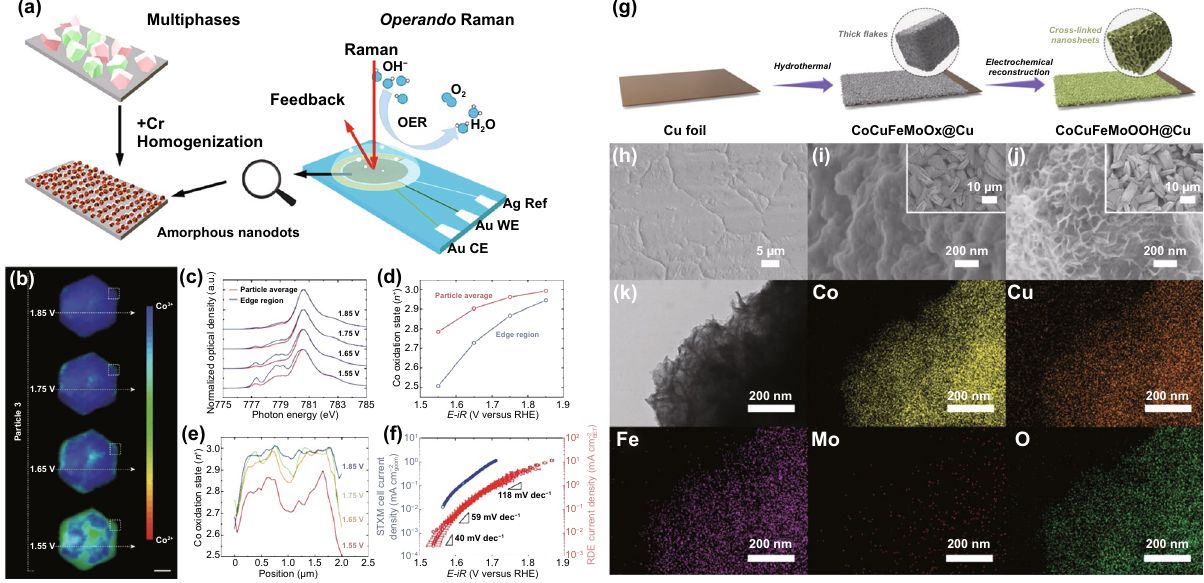
Fig. 14 a Scheme of the amorphization by introducing Cr and operando Raman testing during OER. Reprinted with permission from Ref. [199]. Copyright Year 2020. American Chemical Society. b Phase maps of a β-Co(OH) 2 particle at applied voltages in different OER Tafel regions. Scale bar, 500 nm, c Co LIII-edge STXM–XAS spectra of the particle average and the boxed edge region in a, showing a reduced Co oxidation state at the edge of the particles, d Corresponding Co oxidation state for the full particle average and edge region from the Co